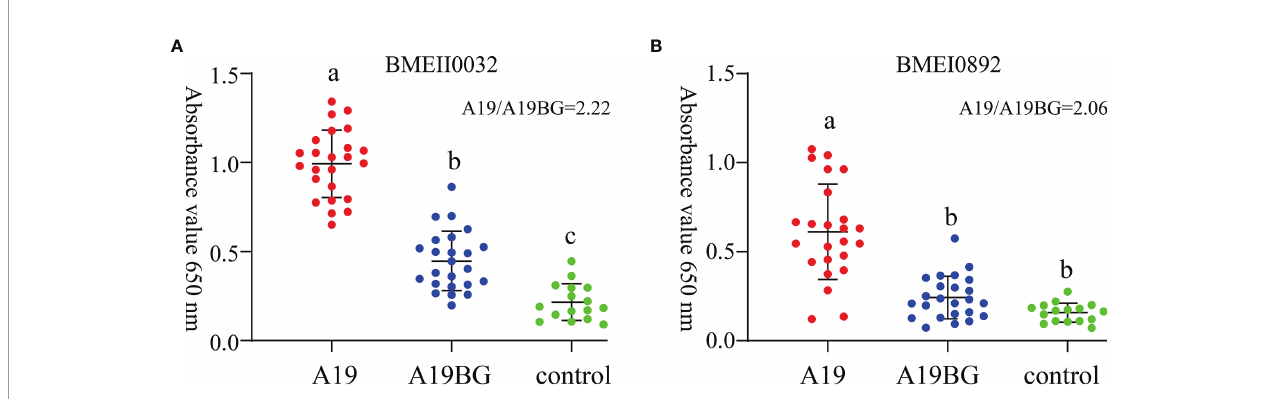
FIGURE 5 | Immune response of BMEII0032 and BMEI0892 to A19 and A19BG immunisation sera. (A) , Immune response of BMEII0032 to A19 and A19BG immunisation sera. (B) , Immune response of BMEI0892 to A19 and A19BG immunisation sera. Means ± SEs, n =24, ELISA for Brucella negative sera as control, different letters indicate signi fi cant differences among treatments based on the least signi fi cant difference at P ≤